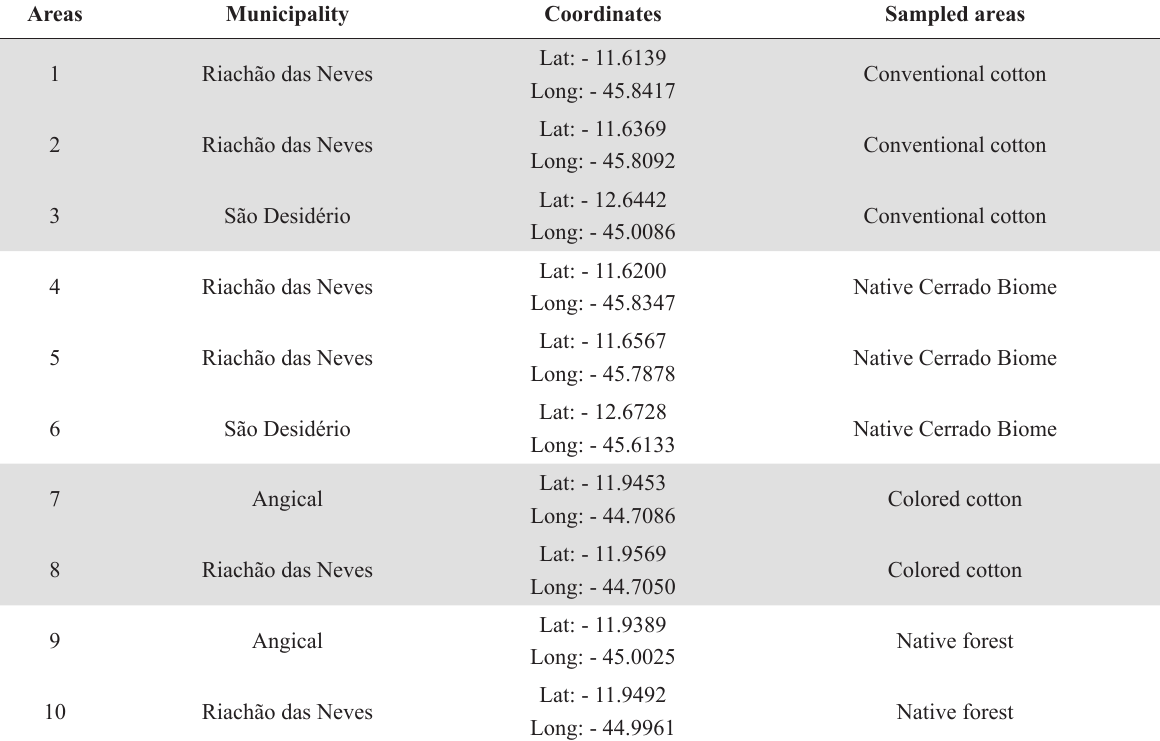
Soil sampling areas (municipalities and respective geographic coordinates in decimal degrees) in cotton farming systems and native vegetation in the Bahia State,